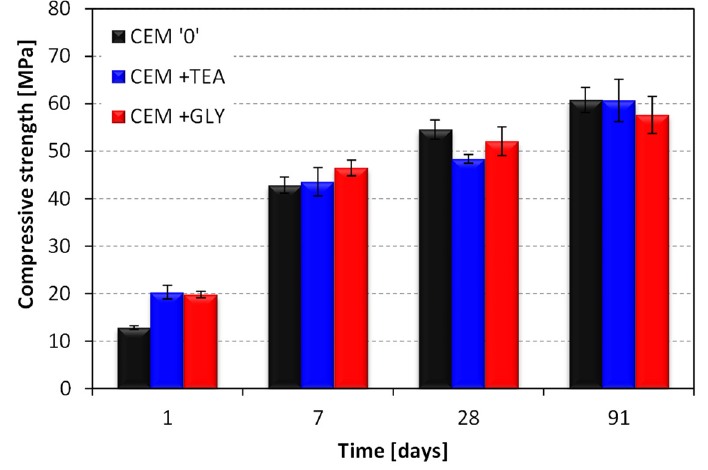
Figure 6. Compressive strength of standard mortars, w/c = 0.5.